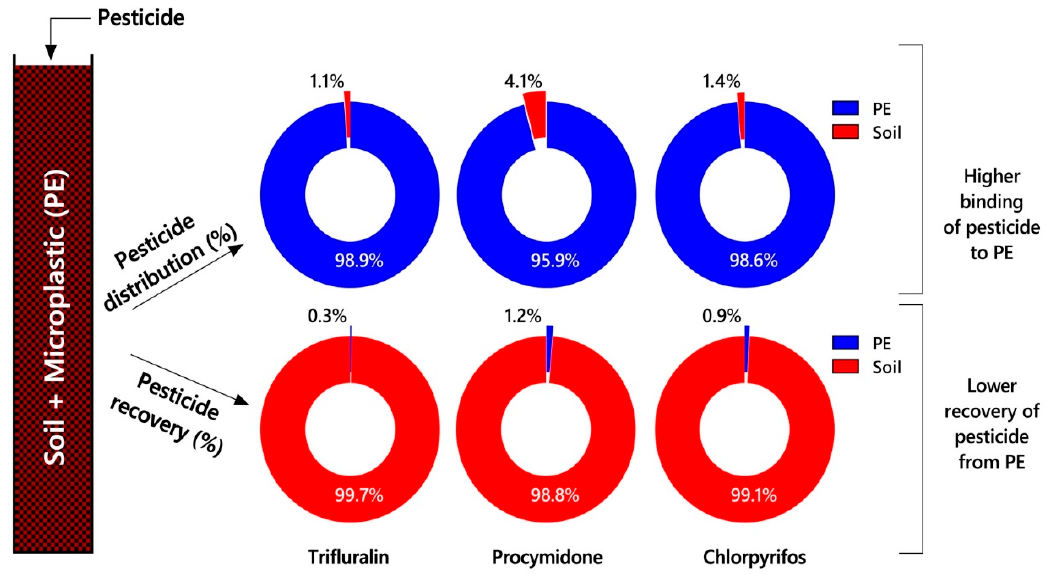
Figure 2. Distribution and recovery of pesticides in a soil + microplastics column (based on data from Ramos et al. [136]) (PE—Polyethylene).